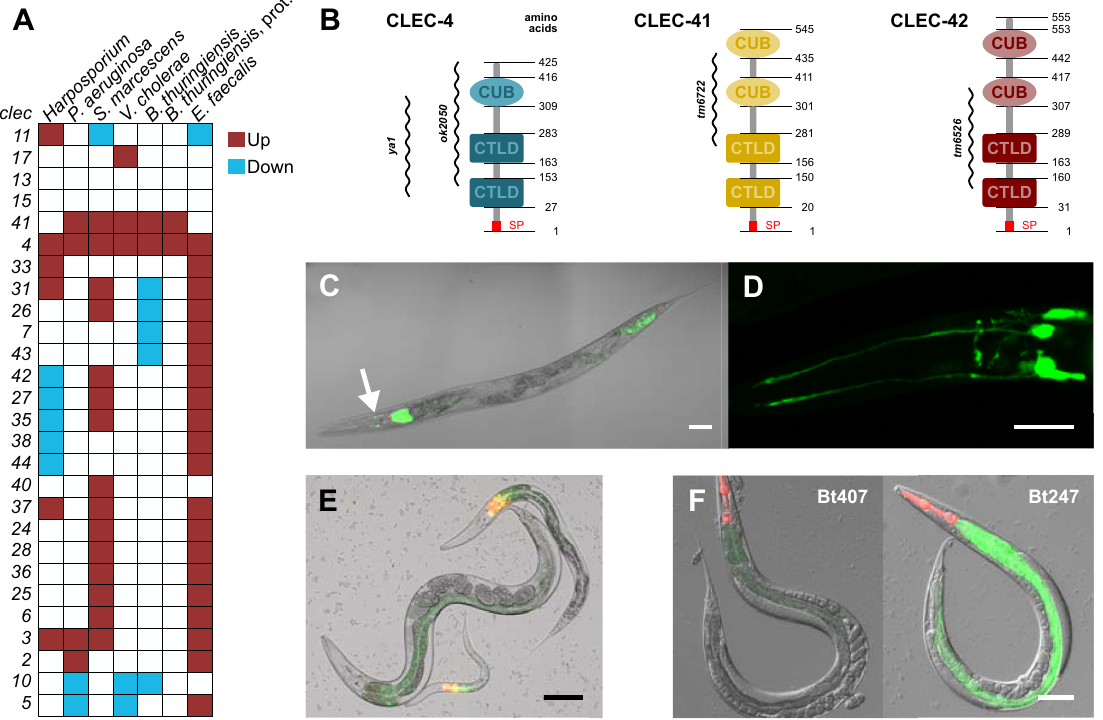
Fig 1. clec-4 , clec-41 , and clec-42 expression and protein domain architecture. (A) Heatmap showing the differential expression of clec-4 and a subset of its paralogs in worms exposed to different pathogens. Note that one Bt column is based on proteome data (prot.). 15 clec-4 paralogs, which did not exhibit a differential expression have been excluded. Genes are vertically sorted by hierarchical clustering using Cluster 3.0 [40]. Red and blue colors indicate up- and downregulation, respectively. Transcriptomic data taken from previously published studies [7, 12, 45, 47–49] and GSE110913 were analyzed using WormExp [49]. (B) Domain architecture of the CLEC-4, CLEC-41, and CLEC-42 proteins adapted from SMART (http://smart.embl-heidelberg.de/) taking UniProt as source database. Numbers represent the amino acid position, the regions affected by deletions in the respective mutants are indicated on the side. SP = signal peptide. (C-F) In vivo expression of clec-4 , clec-41 , and clec-42 . (C, D) Expression of clec-4 p::GFP (C) throughout the intestine (most strongly in the first intestinal ring (int1) and the posterior intestine), in the amphid neurons (white arrow) of a L4 larva, and (D) in the amphid neurons and amphid nerves in the head of a L1 larva. The scale bar represents 50 μ m in (C) and 10 μ m in (D). (E) Simultaneous expression of clec-41 p:: GFP and clec-42 p::mCherry throughout the intestine and in int1 at different larval stages, respectively. The scale bar represents 100 μ m. (F) Expression of clec-41 p::GFP in the intestine upon exposure to the non-pathogenic Bt407 and the pathogenic Bt247. The co-injection marker myo-2 p::mCherry is expressed in the pharynx. The scale bar represents 100 μ m. Also see S1 Fig.